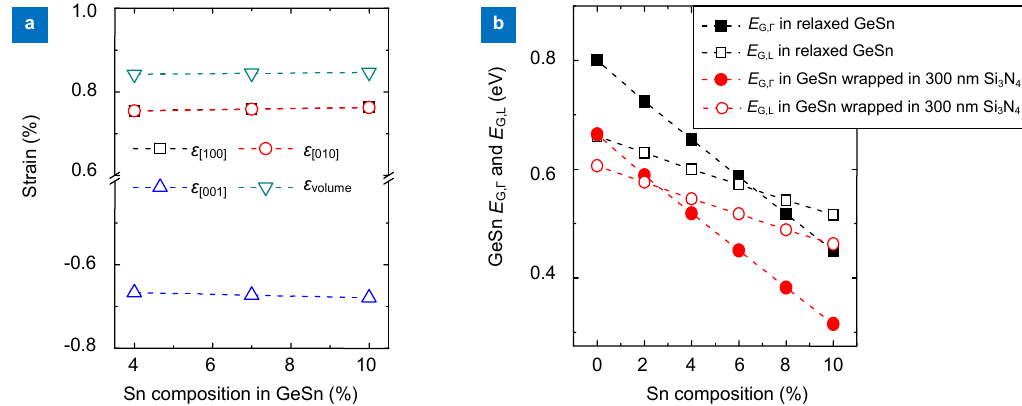
Fig. 11 | ( a ) Modeled strain components as a function of Sn composition in the intrinsic GeSn layer. ( b ) Comparison of E G, Γ and E G,L in relaxed and strained GeSn with various Sn compositions. Figure reproduced from ref. 37 , Optical Society of America.